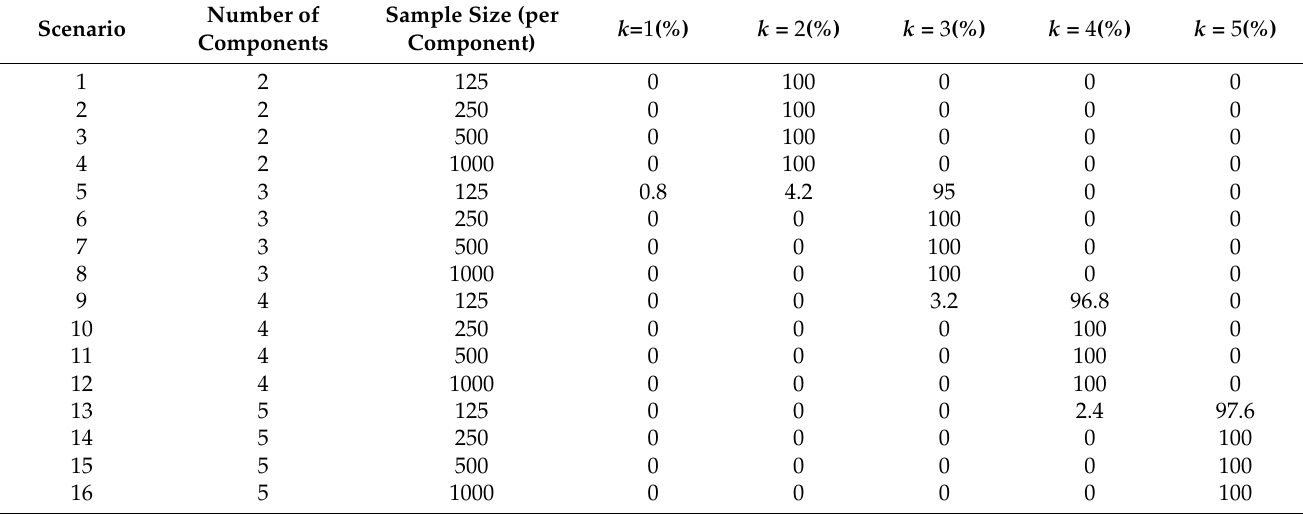
Table 2. Summary of the results of grouping the EV-I mixture distribution with 200,000 sweeps and replicated 500 times.